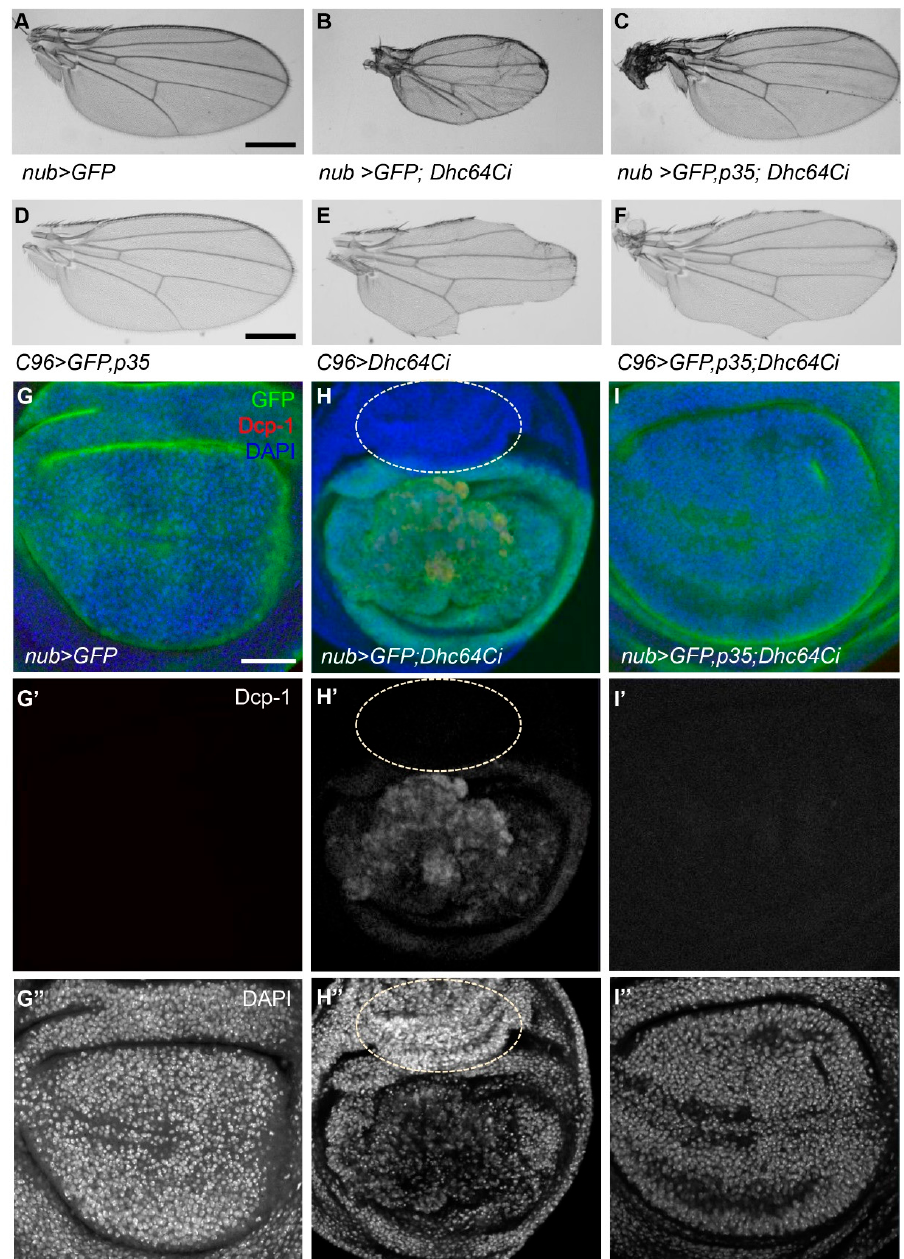
Figure 3. The knockdown of Dhc64C induces apoptosis. ( A–C ) Knockdown of Dhc64C induces small wing phenotype, which can be rescued by coexpression of p35. Compared to control nub-Gal4/+ wings ( A ), nub > GFP; Dhc64Ci wings from rare survivors cultured at 18 °C are small and wrinkled ( B ), and nub > GFP, p35; Dhc64Ci wings are normal ( C ). Scale bar 500 um. n = 10 each. ( D – F ) Compared to the normal C96 > GFP, p35 wings ( D ), C96 > Dhc64Ci wings are severely notched ( E ). This notching phenotype of C96 > GFP; Dhc64Ci wings is noticeably rescued by p35 ( F ). Scale bar, 500 um. n = 10 each ( G – I ) Knockdown of Dhc64C in the wing pouch region induces both apoptosis and cell proliferation, which are rescued by p35. Activated Dcp1 is detected in wing discs of the nub > GFP; Dhc64Ci flies ( H’ ), which are not detected from nub>GFP and nub>GFP,p35;Dhc64Ci ( G’,I’ , respectively) DAPI staining shows overall organization of wing pouch cells ( G” – I” ). All apoptosis-related phenomena are rescued by coexpression of p35 ( I ). Abnormal growth of hinge region outside of nub- Gal4 -expressing region is marked with dotted circles ( H – H’’ ). Anterior to the left. Scale bar 100 um.